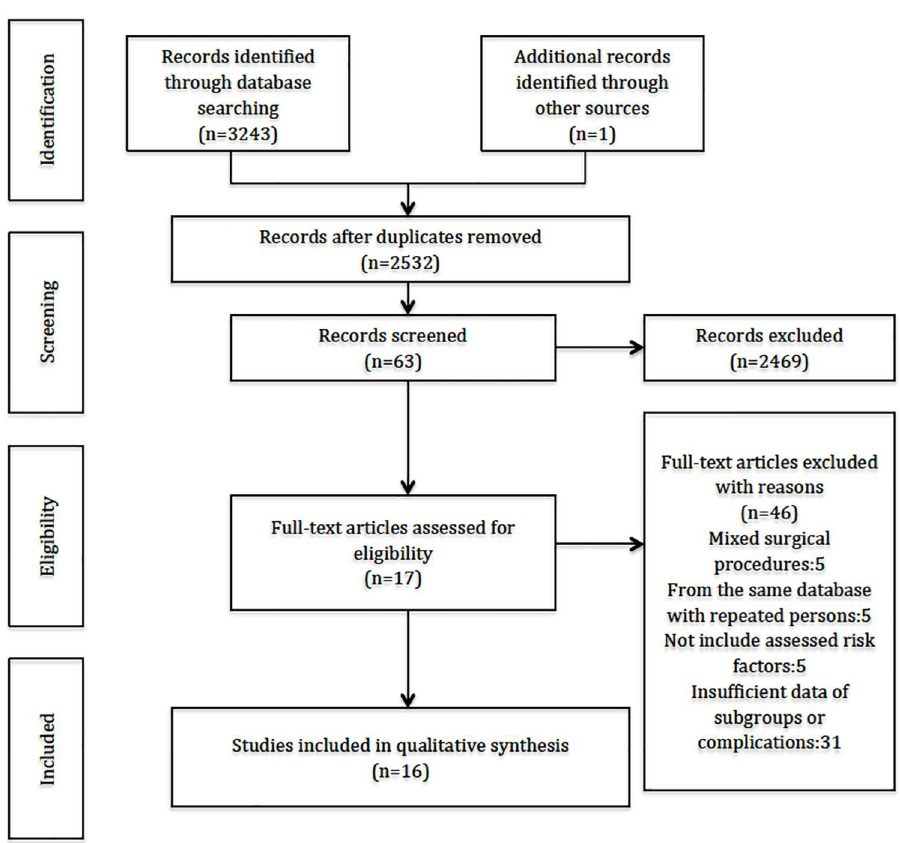
Fig 1. PreferredReporting Items for Systematic Reviews and Meta-Analysis flow diagram, literature search, and selection process.